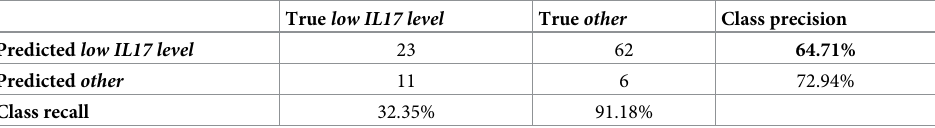
Table 5. Performance parameters of classification model targeting binary labeling low IL17 level vs. other . Accu- racy 71.64%